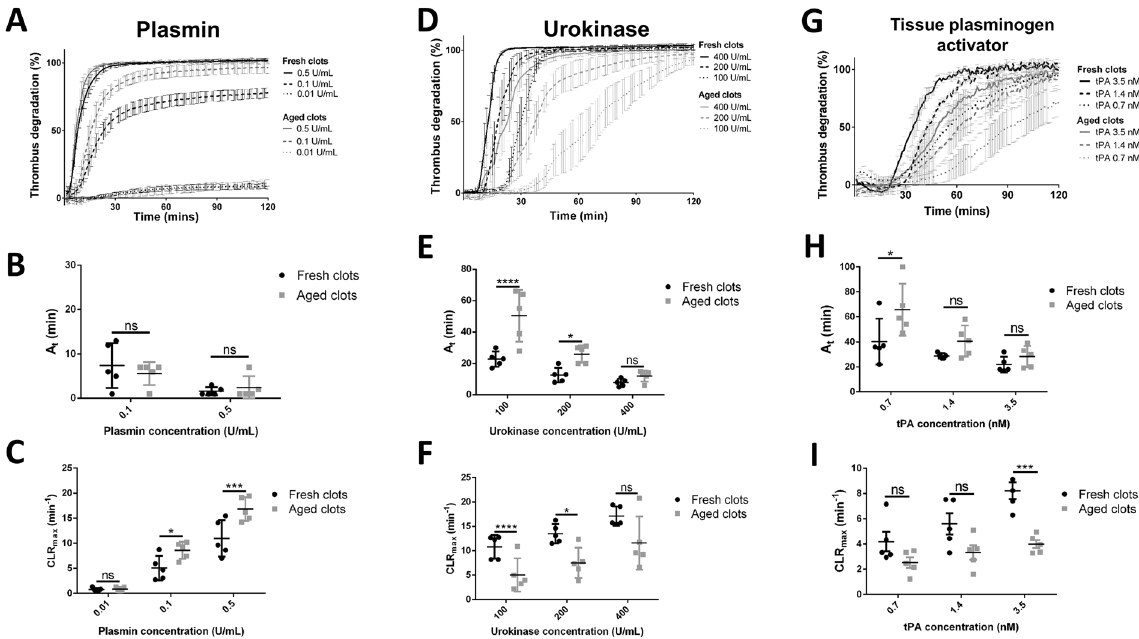
Figure 4. Effect of thrombus maturation on thrombolysis. Thrombolysis profiles were measured with the Halo assay method after 30 minutes incubation (Fresh clots) and after 4 hours incubation (Aged clots) with 0.5 U/ mL, 0.1 U/mL and 0.01 U/mL plasmin ( A ), with 400 U/mL, 200 U/mL and 100 U/mL urokinase ( C ) and with 0.35 nM, 0.7 nM, 1.4 nM, 3.5 nM and 7 nM t-PA ( F ). Activation times ( D and G ) and maximal clot lysis rates ( B , E and H ) were presented for each concentration as mean values ± SD (n = 5, ns: not significant, * p < 0.05, ** p < 0.01, *** p < 0.001, **** p <